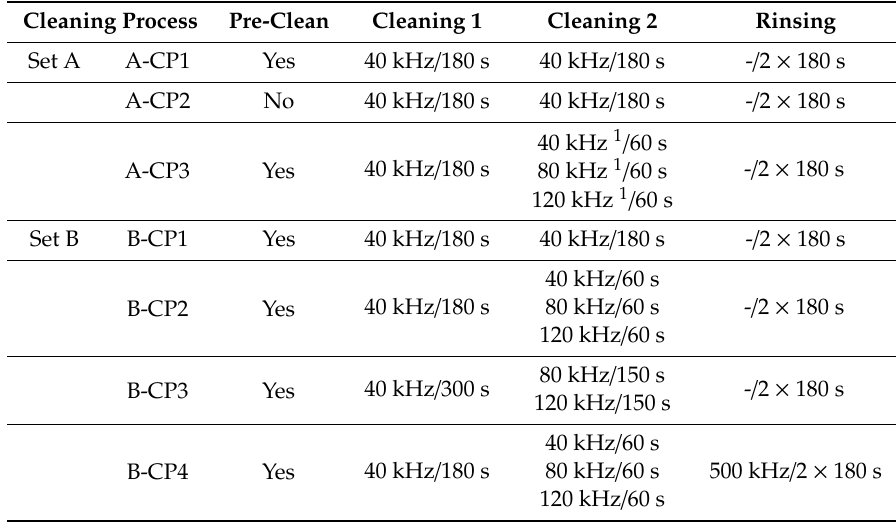
Table 1. Applied ultrasonic frequencies and process times for the ultrasonic cleaning steps as well as the fine-rinsing step used for cleaning processes of set A and set